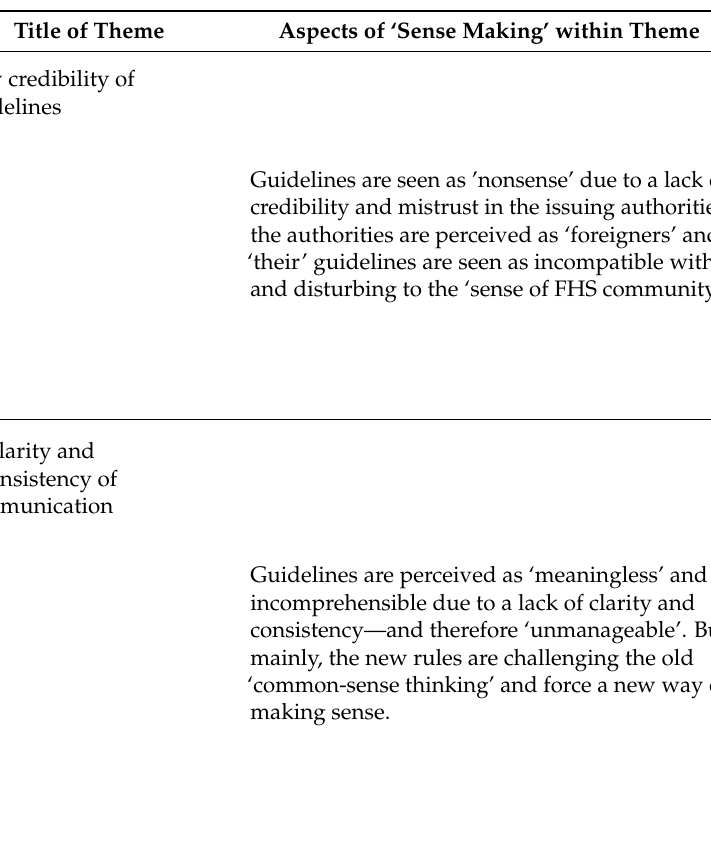
Table 2. Students’ sense-making of the